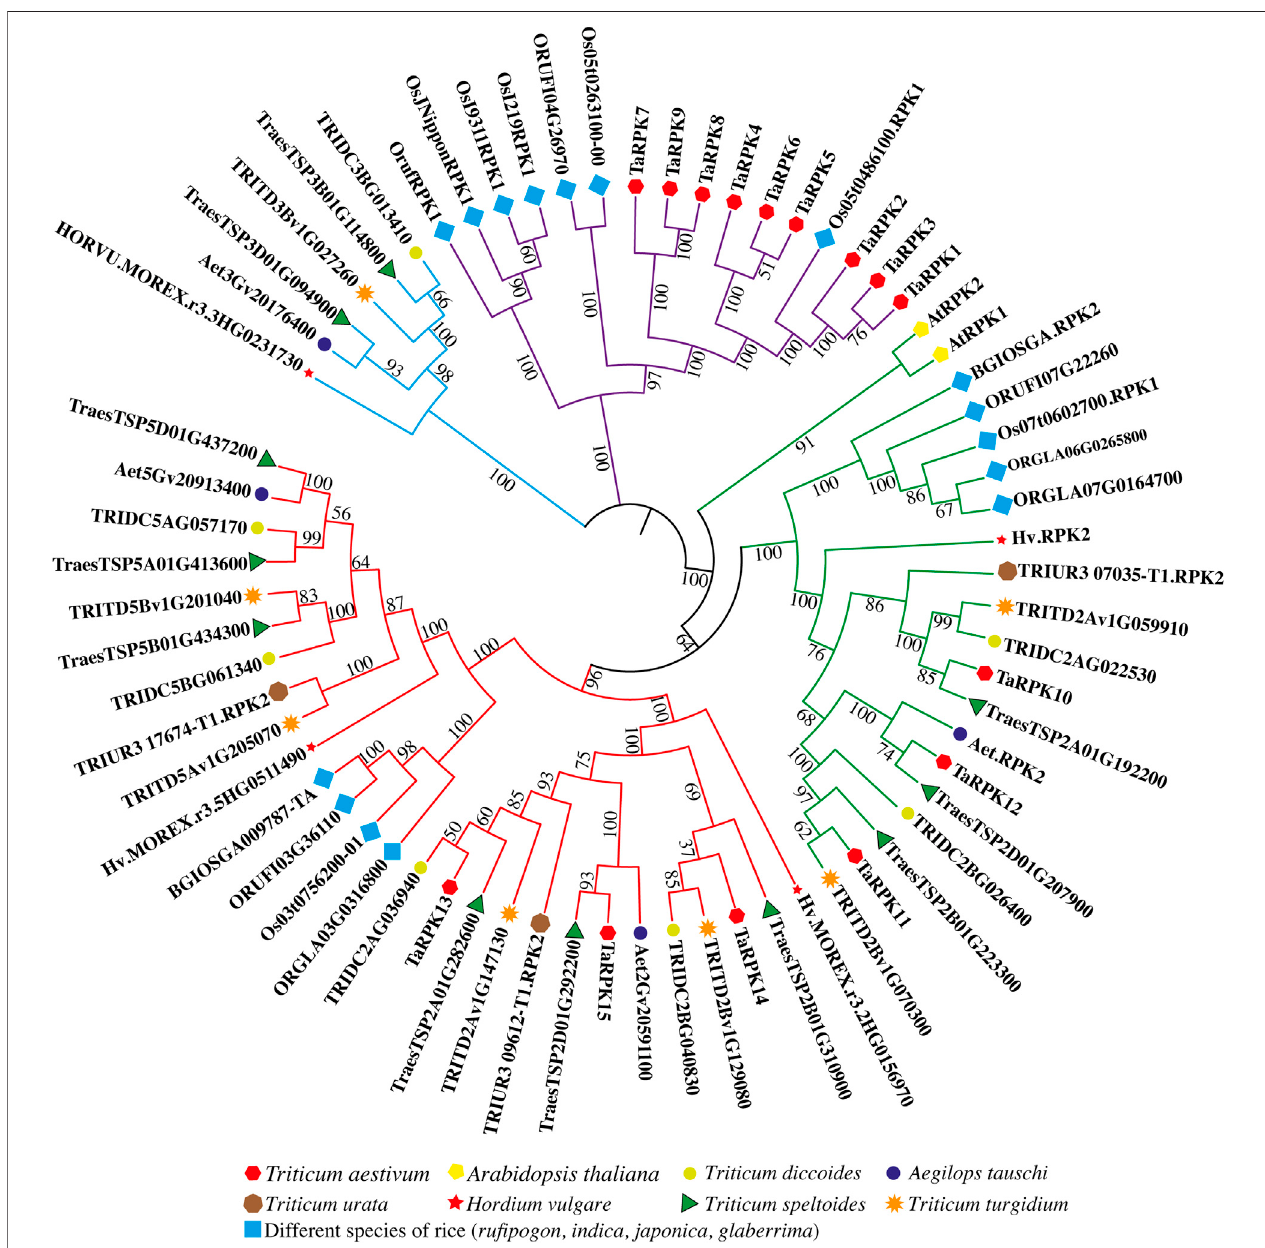
FIGURE 2 | Comparative phylogenetic tree of RPK genes between Triticum aestivum , Triticum dicoccoides , Triticum turgidum , Triticum speltoides , Aegilops tauschii , Triticumurata , Hordeumvulgare , Arabidopsisthaliana, anddifferentspeciesof Oryza ( ru fi pigon , indica , japonica ,and glaberrima ).1,000replicateswereusedfor the bootstrap test, and the replication percentage is presented next to the